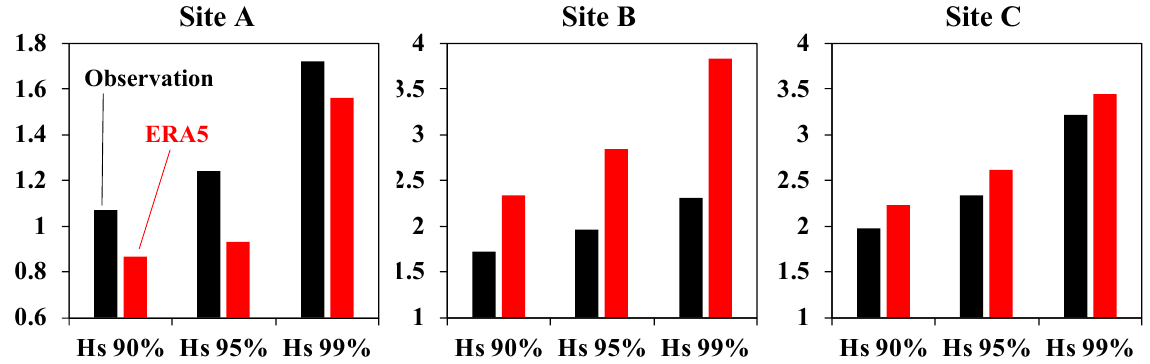
Figure 4. Comparison of ERA5 model output (red) with in situ measured data (black) in statistical 90%, 95%, and 99% significant wave heights ( Hs , m). The left, middle, and right panels display the results of Sites A, B, and C, respectively.